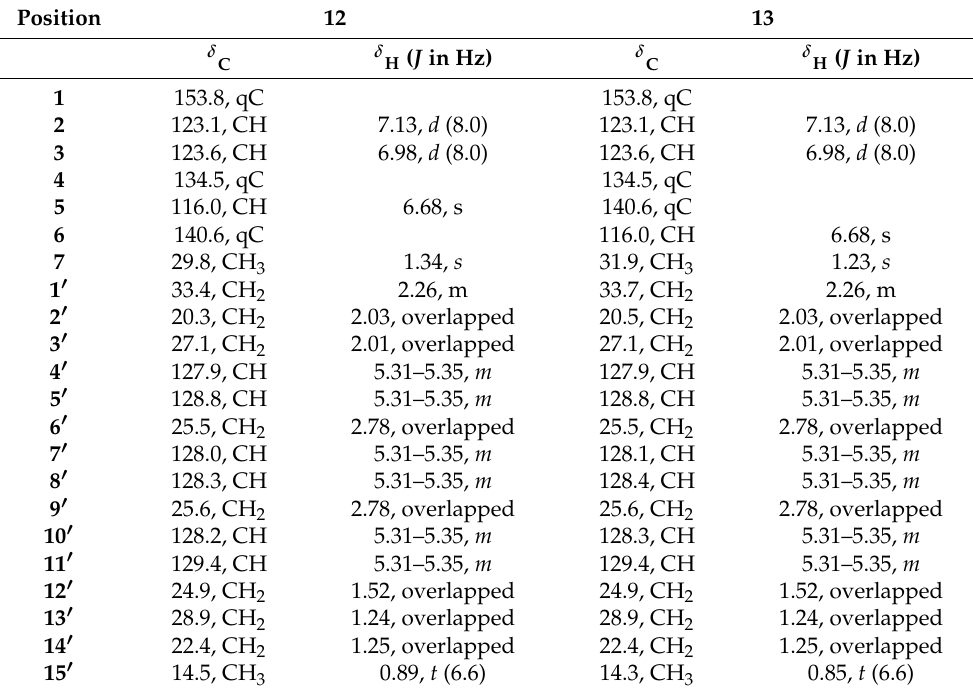
Table 1. Distortionless enhancement by polarization transfer-Q (DEPT-Q) (400 MHz) and 1 H (100 MHz) NMR data of compounds 12 , 13 in DMSO- d 6 ; carbon multiplicities were determined by the DEPT-Q experiments.